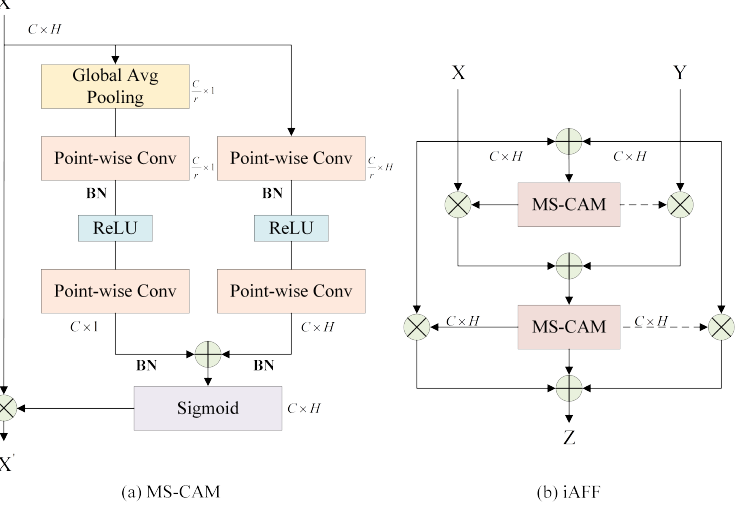
Figure 4. The structure of the iterative Attentional Feature Fusion (iAFF) module. ( a ) The core component of iAFF module called Multi-scale Attention Mechanism (MS-CAM). ( b ) The structure of iAFF